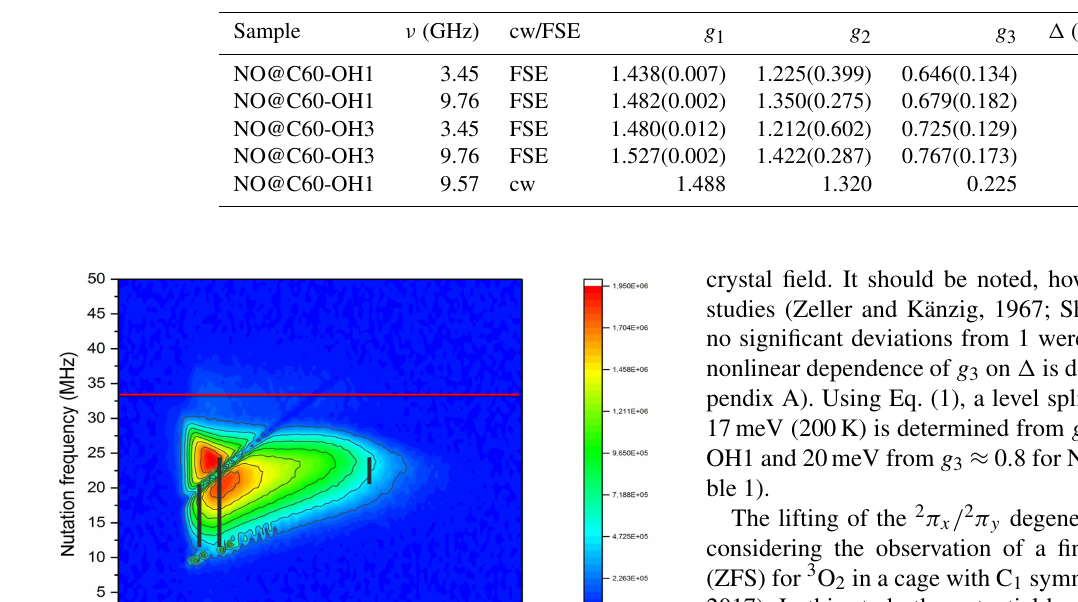
Table 1. Fit-determined g matrix data of both compounds (gStrain fit parameters are listed in brackets). Previously published values (Hasegawa et al., 2018a) are given for comparison. Level splittings (cid:49) deduced from the deviation of the pseudo-axial g 3 parameter from g e are also shown.